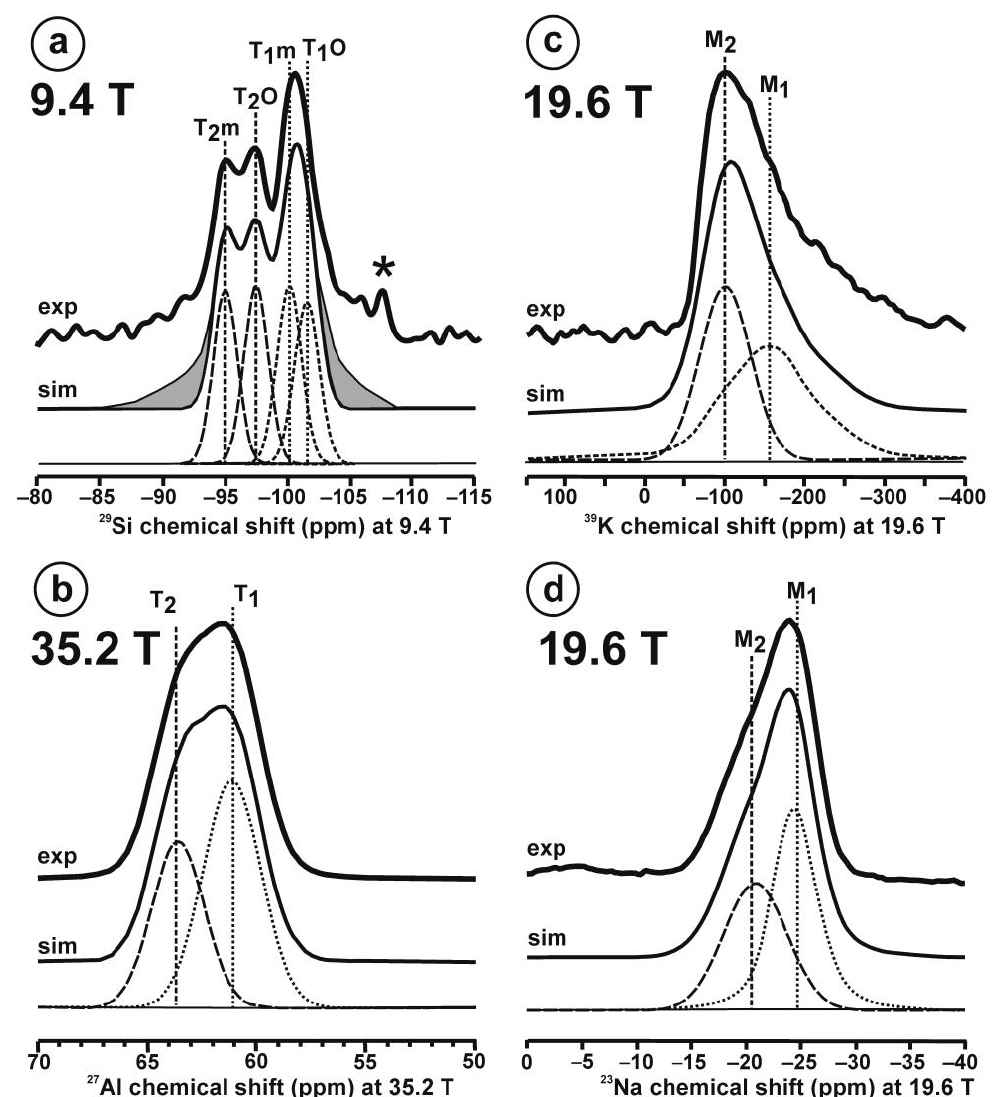
Figure 10. The MAS NMR spectra of “valencianite” KAlSi 3 O 8 (Or 97.5 Ab 2.5 ) in specimen AGM, exp are the experimental spectra and sim are the simulated spectra, indicating the line positions of the resolved two or four T framework tetrahedral sites for Al and Si atoms, as well as two M cavity sites for K and Na atoms.: ( a ) the 29 Si at 9.4 T, for T 1 O and T 1 m sites as dotted curves, T 2 O and T 2 m sites as dashed curves; ( b ) the 27 Al at 35.2 T, for T 1 site in dotted curve, and T 2 site in dashed curve; ( c ) 39 K at 19.6 T for M 1 site in dotted curve, and M 2 site in dashed curve, and ( d ) 23 Na at 19.6 T for M 1 site in dotted curve, and M 2 site in dashed curve. The simulated area in the 29 Si spectrum is ca. 86% of the total signal, and additional signals could be located at − 91.6 ppm (~6.7%) and − 104.4 ppm (~7.7%). The asterisk (*) indicates the resonance from quartz SiO 2 at –107.1 ppm. The c.g. of the 27 Al spectrum is at 62.1 ppm. See explanations in text and Table 5 for the deconvolution of the signals. The details of the experimental procedure for ( a ), ( b , d ) are given in [4]; for the 27 Al spectrum at 35.2 T in ( c ), see Figure 1.